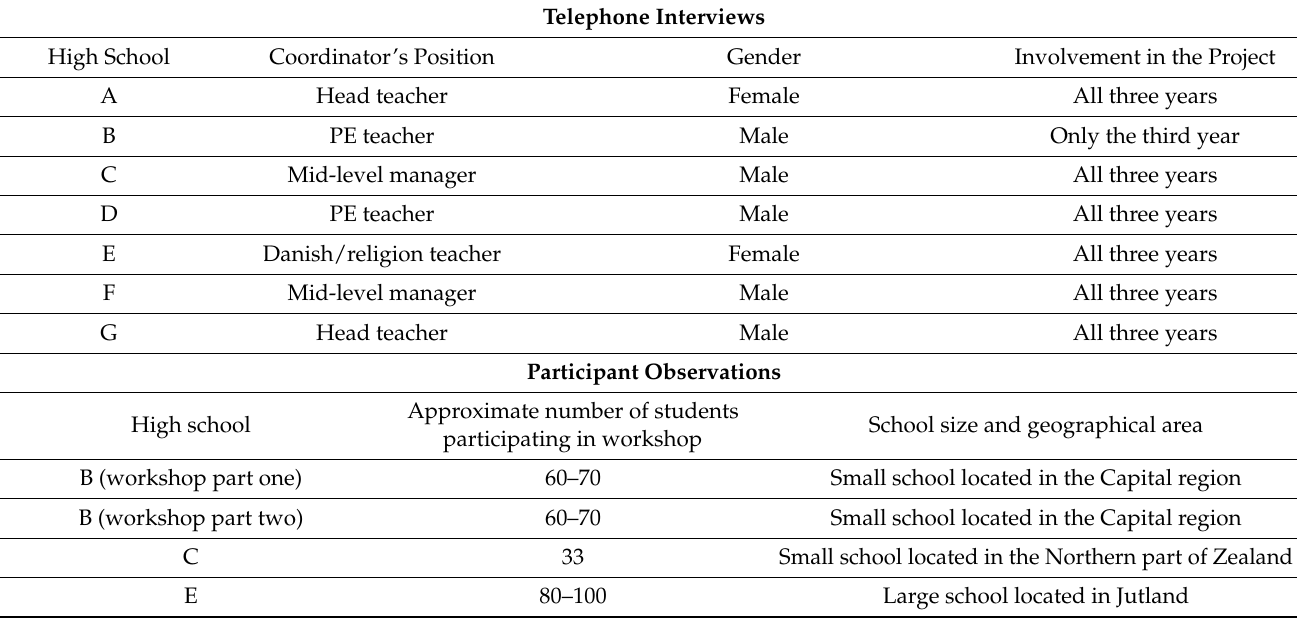
Table 1. Overview of participants in the data